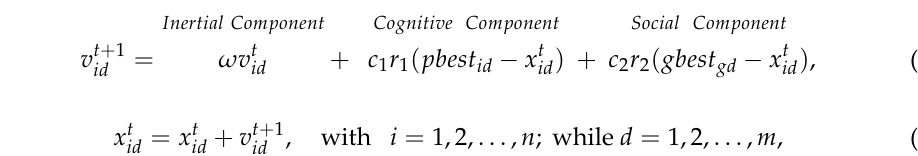
Figure 3. The architecture of the cascade forward neural Network (CFNN) [24].